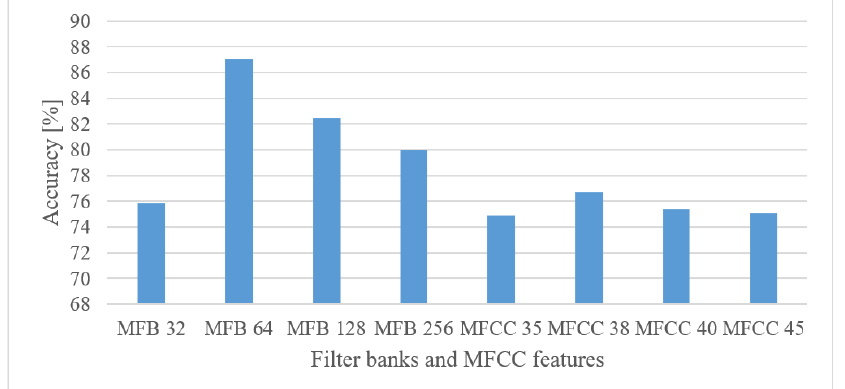
Figure 15. Accuracies for 32, 64, 128, and 256 Mel FBs, and 35, 38, 40, and 45 MFCC coefficients for a frequency range of 100 Hz–17.5 kHz.